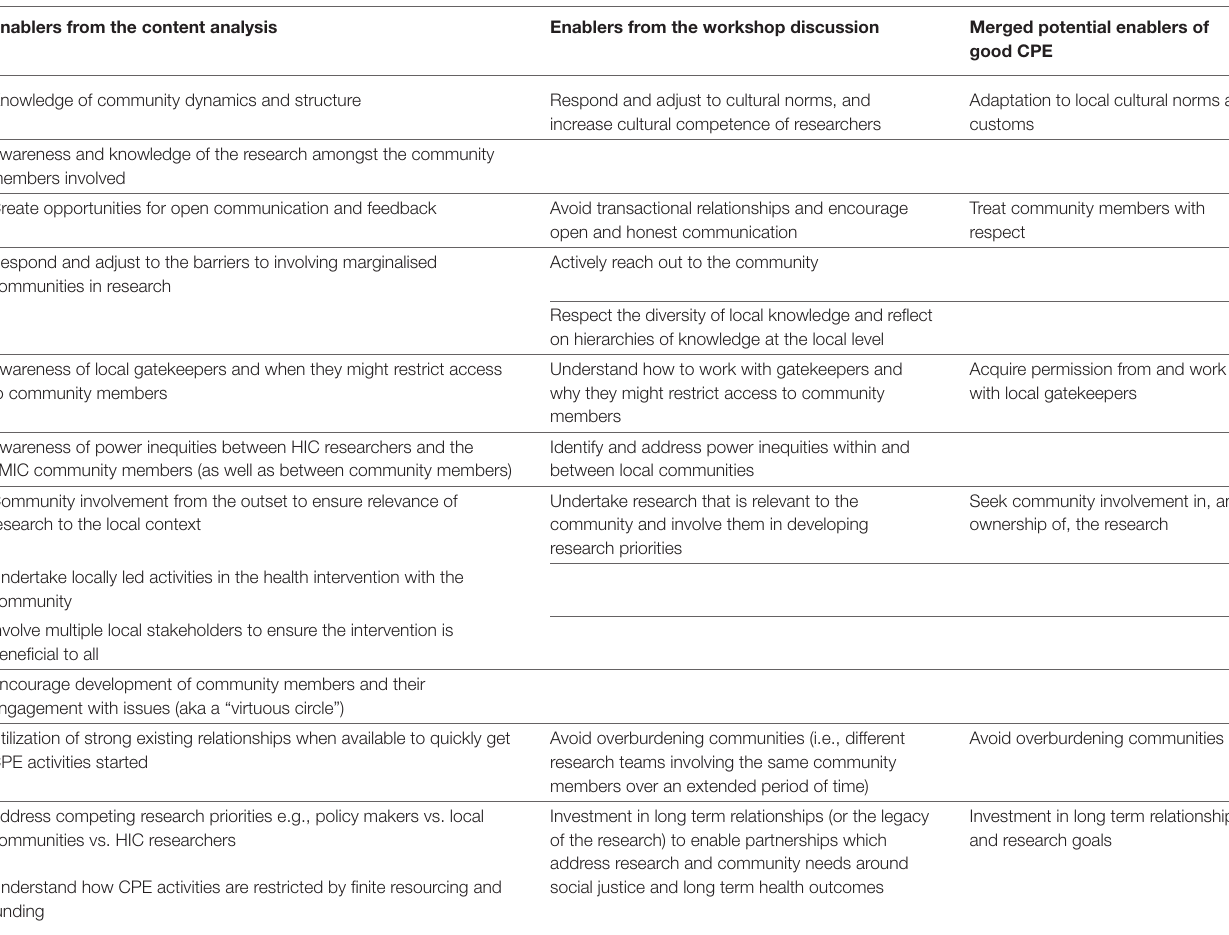
TABLE 2 | Potential enablers of good community and public engagement (CPE) as identified through the content analysis, workshop discussions and the merged findings of these two processes. Enablers from the content